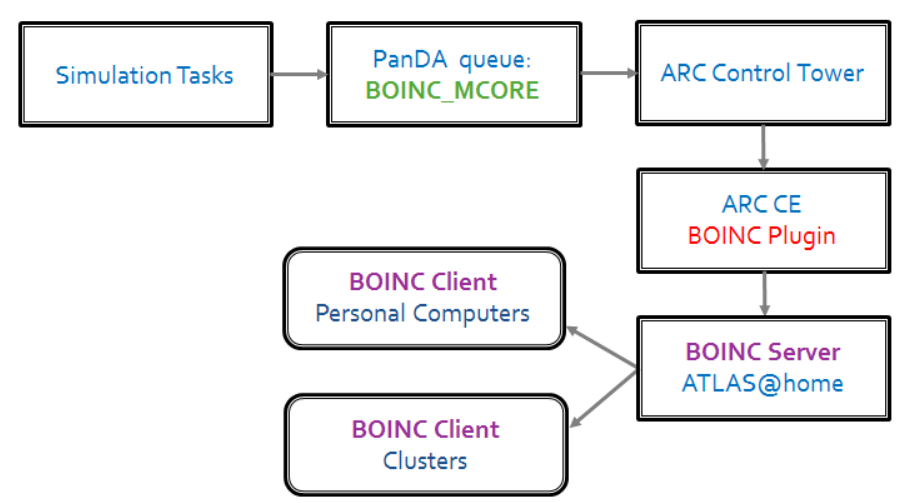
Figure 1. ATLAS@home architecture and